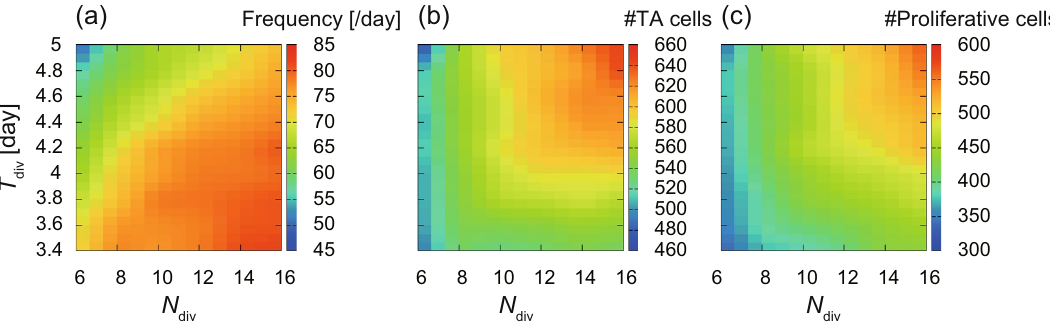
Figure 3. The ability of cell supply in the basal layer as a function of N div and T div . ( a ) The frequency of cell division events in the basal layer per day. ( b ) The number of basal cells. ( c ) The number of proliferative bulk thickness. These measures can capture different features: A cell layer with uniform thickness and a well- defined boundary with the adjacent cell layer should have small G and E . Figure 2 shows the evaluation measures as a function of N div vs T div . In the granular layer, the parameter space can be divided into two regions [Fig. 2(b)]: In the lower-right region, where the cell supply rate is large (with large N div and small T div ), the thickness H is high and both the dispersion G and the spatial variation E (normalized by the thickness H ) are small, indicating a spatially uniform, well-defined granular layer. On the other hand, in the upper-left region, where the cell supply rate is small (with small N div and large T div ), the opposite tendency is observed, with small H , large G / H , and large E / H , indicating a thin bulk layer with large spatial variation of the thickness and with many isolated cells from the bulk. The same tendency is seen in the cornified layer [Fig. 2(c)]: in the lower-right region, the cornified layer also has large H and small G and E . We note, however, that the parameter region that produces large G and E values is narrower in the cornified layer than in the granular layer and that the magnitude of G and E is the larger in the granular layer, which suggests that the maintenance of the granular layer is more crucial for epidermal homeostasis. The same tendency is also found in the intercellular lipids. As shown in Fig. 2(d), the upper-left region of the N div - T div space shows both the decrease of the mean lipids released from individual cells (normalized by maximum lipid production) and the increase of the number of lipid-deficient cornified cells, defined as cells with lipid production less than 50% of the maximum. The appearance of lipid-deficient cells is also visible in Fig. 1(h). These results suggest that sufficient cell supply is required for lipid production, as well as structural stability. We directly confirmed the relation between the cell supply from the basal layer and the parameters N div and T div . Figure 3(a) shows the mean frequency of cell division events in the basal layer per day, which is low in the upper-left region, as expected. Note that the frequency is approximated by the number of proliferative cells divided by T div . The number of proliferative cells depends on the surface area of the basal layer, which also varies by these parameters. Figures 3(b) and 3(c) show the number of basal cells, which is proportional to the surface area of the basal layer, and the number of proliferative cells, respectively, which indicates that both the surface area and the number of proliferative cells increase as N div increases. Note that the increase of T div , implying the reduced division frequency, does not necessarily reduce the surface area. On the contrary, the surface area increases as T div increases for large N div values, presumably because TA cells are more easily crowded out from the basal layer when cell division occurs more frequently.